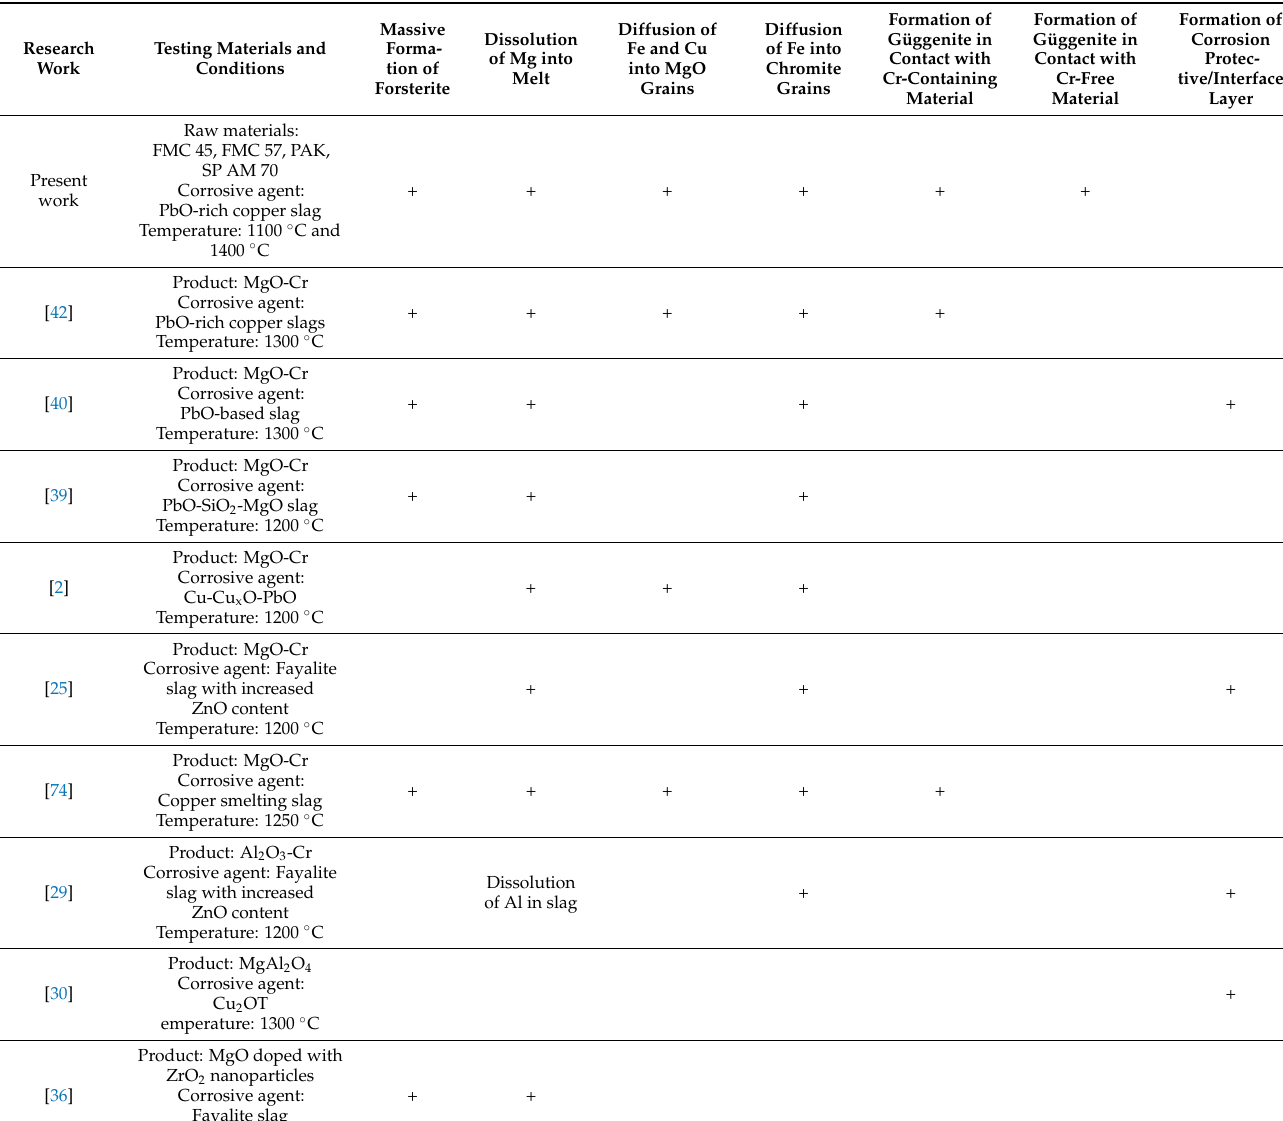
Table 10. Comparison of results obtained in the present study with other works. MgO-Cr—magnesia– chromite product, Al 2 O 3 -Cr—alumina–chromite